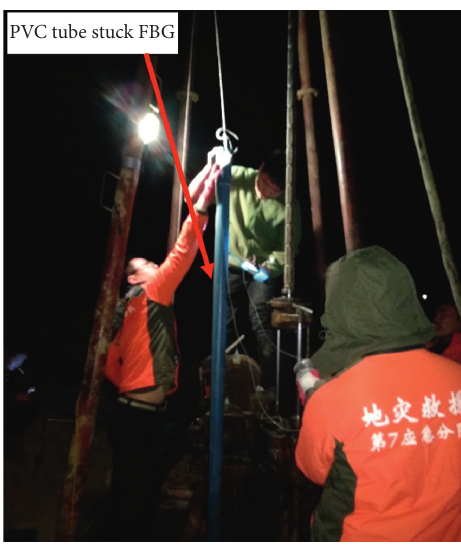
Figure 9: Field installation of fiber grating monitoring